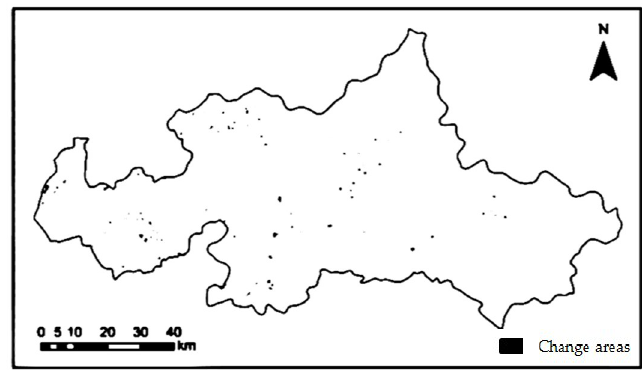
Figure 9. Detected change areas based on phenological trajectory similarity (in black).